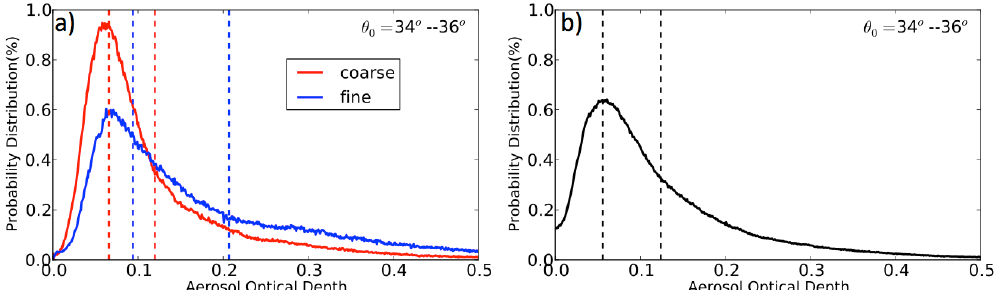
Figure 1. Probability distributions of aerosol optical depth retrieved from Ed4SSF using Terra measurements from 2000 to 2005 for θ 0 = 34– 36 ◦ . (a) For glint angle > 40 ◦ , the AOD threshold values are 0.066 and 0.12 for coarse-mode-like aerosols and are 0.094 and 0.207 for fine-mode-like aerosols. (b) For glint angle ≤ 40 ◦ , the AOD threshold values are 0.056 and 0.124.